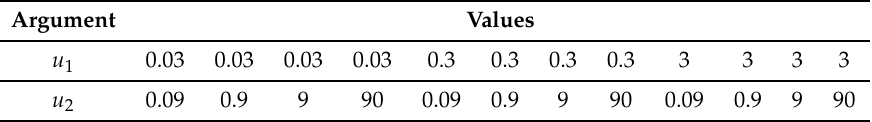
Table 1. Selection of pairs of u 1 , u 2